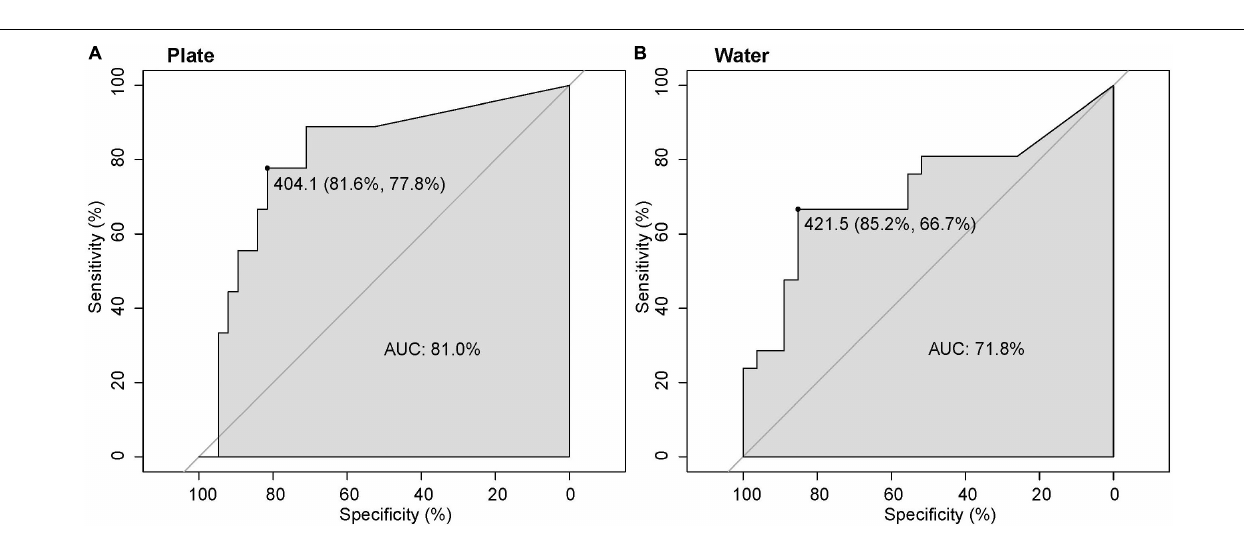
FIGURE 2 | Receiver operator characteristics (ROC) with DNA copy numbers used as a predictor of S. spallanzanii RNA presence (binary classifier), for plate (A) and water (B) samples. The area under curves (AUC) represents a measure of the response to the predictor, where 100% represents a perfect predictor, and 50% a non-informative predictor. An estimate of an optimal threshold is indicated, showing the DNA copy number corresponding to the best specificity-sensitivity combination (specificity, sensitivity% in